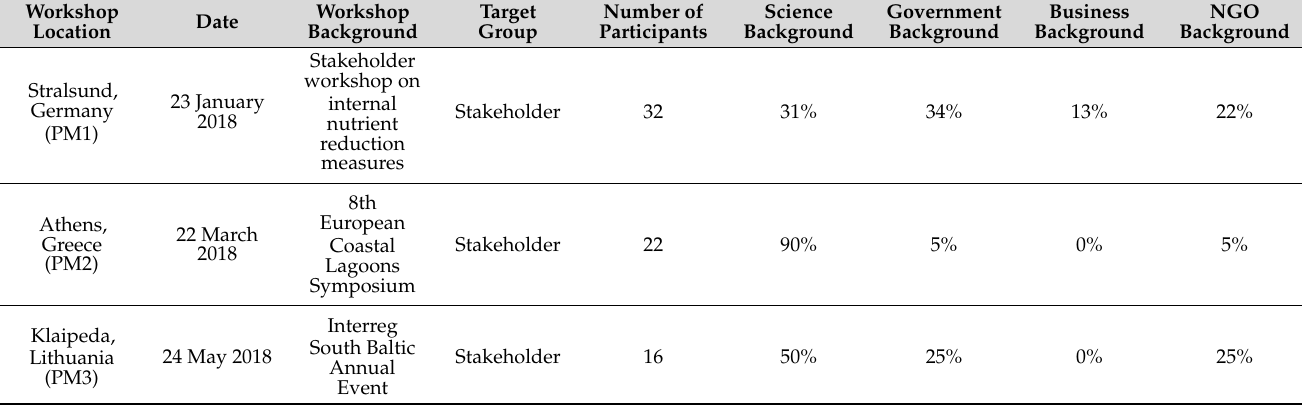
Table 1. Overview of workshops in which the participatory mapping approach was